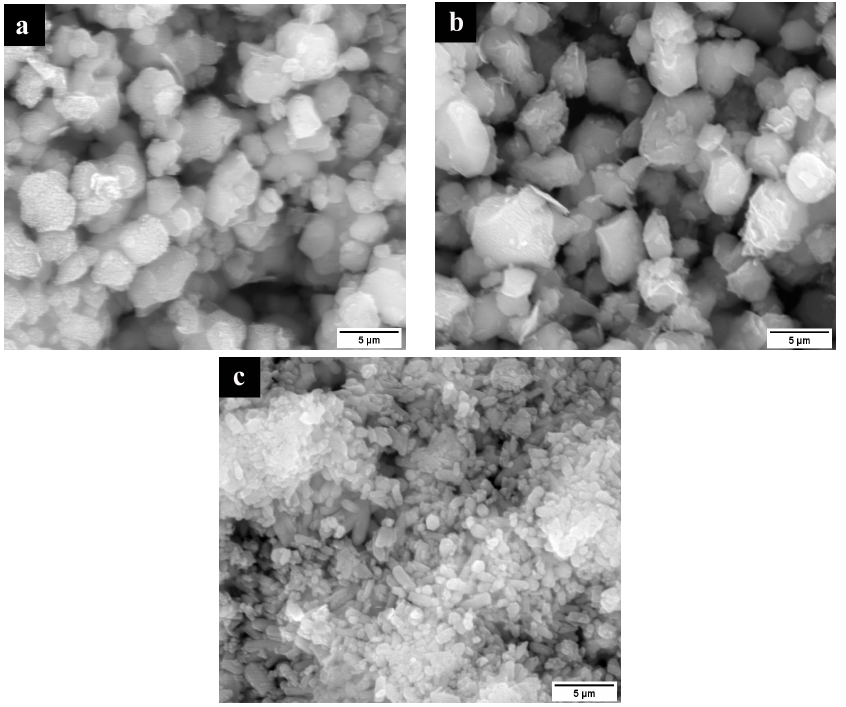
Fig. 5. (a)Morphology 850 o C HAp, (b) 900 o C HAp, and (c) commercial